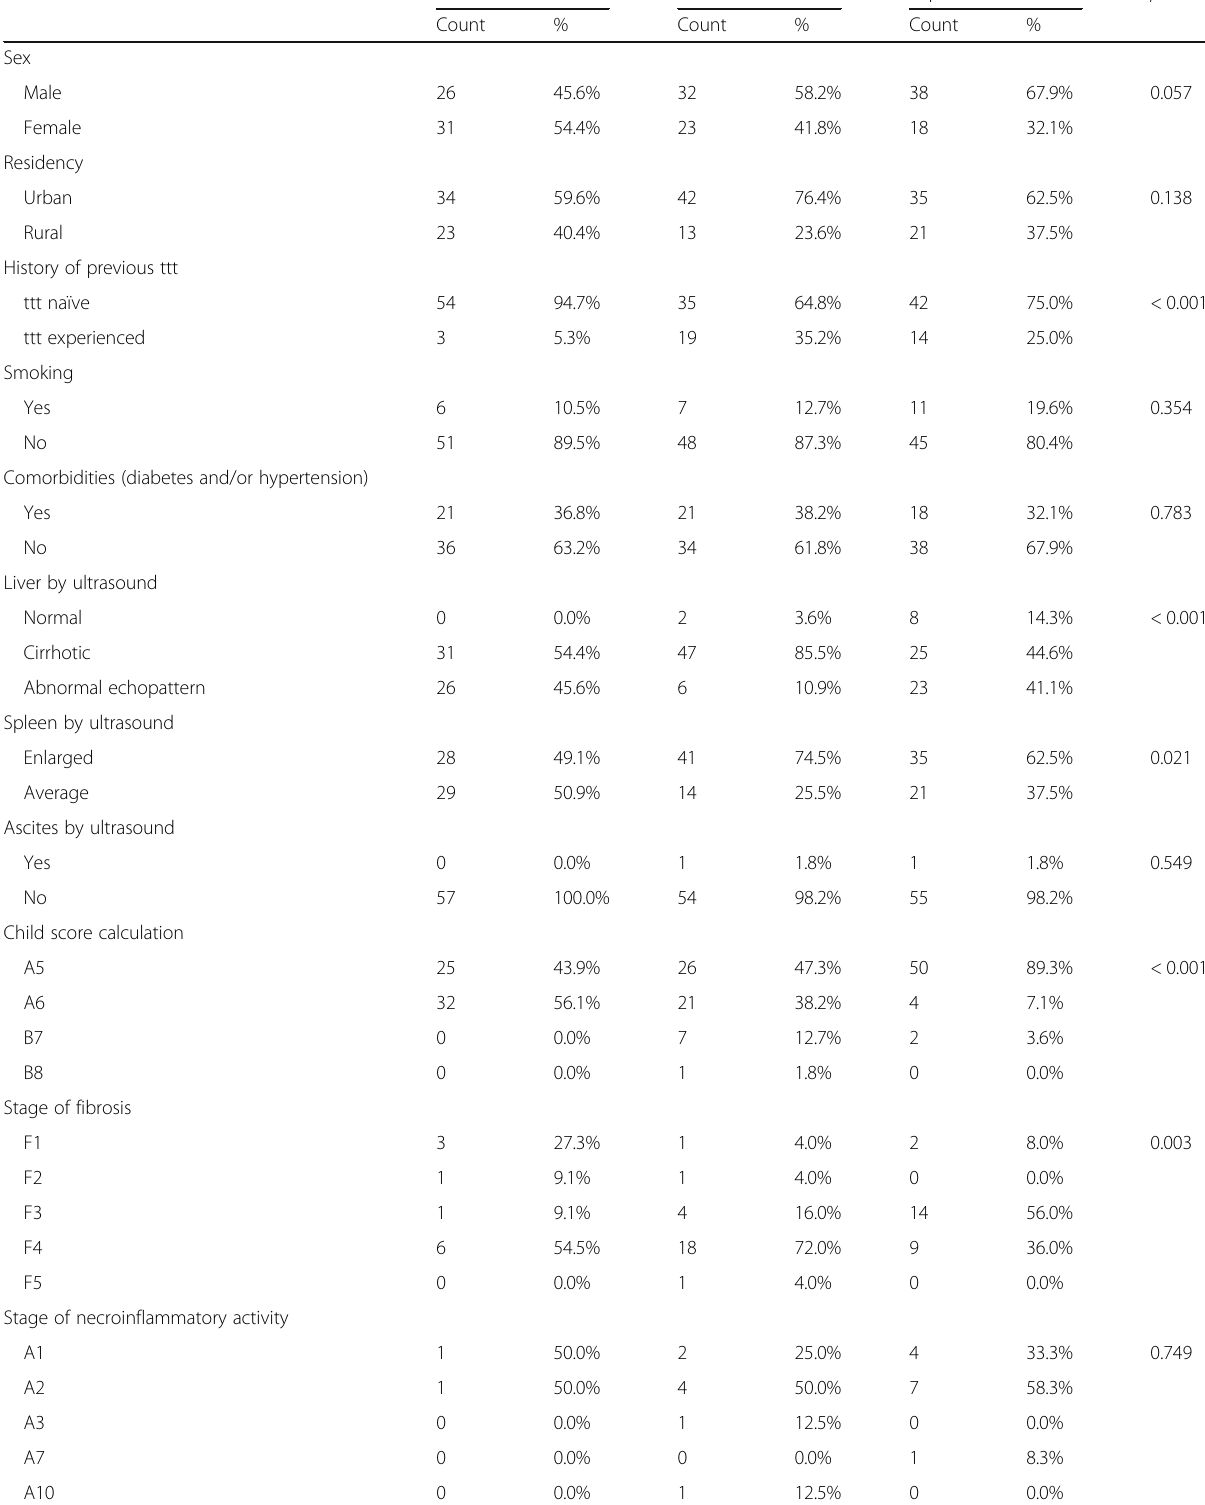
Table 1 Non parametric parameters of the three groups on anti-HCV treatment